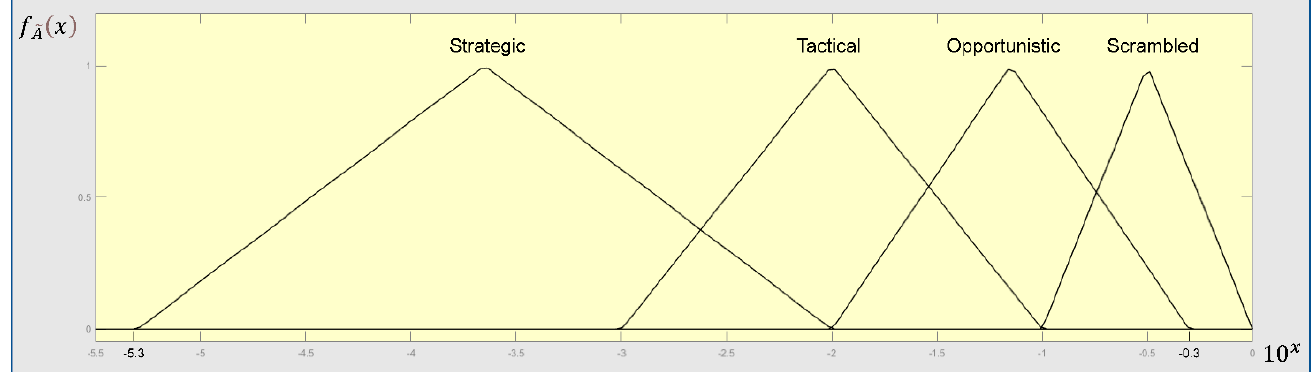
Figure 8. The fuzzy membership functions for the COCOMs.